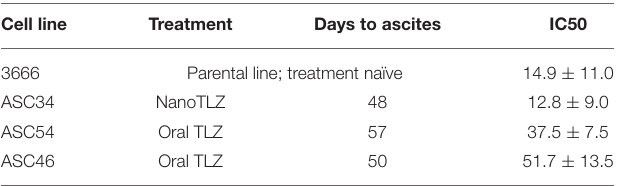
TABLE 1 | Overview of cell lines derived from tumor ascites and corresponding IC50 values. Cell line